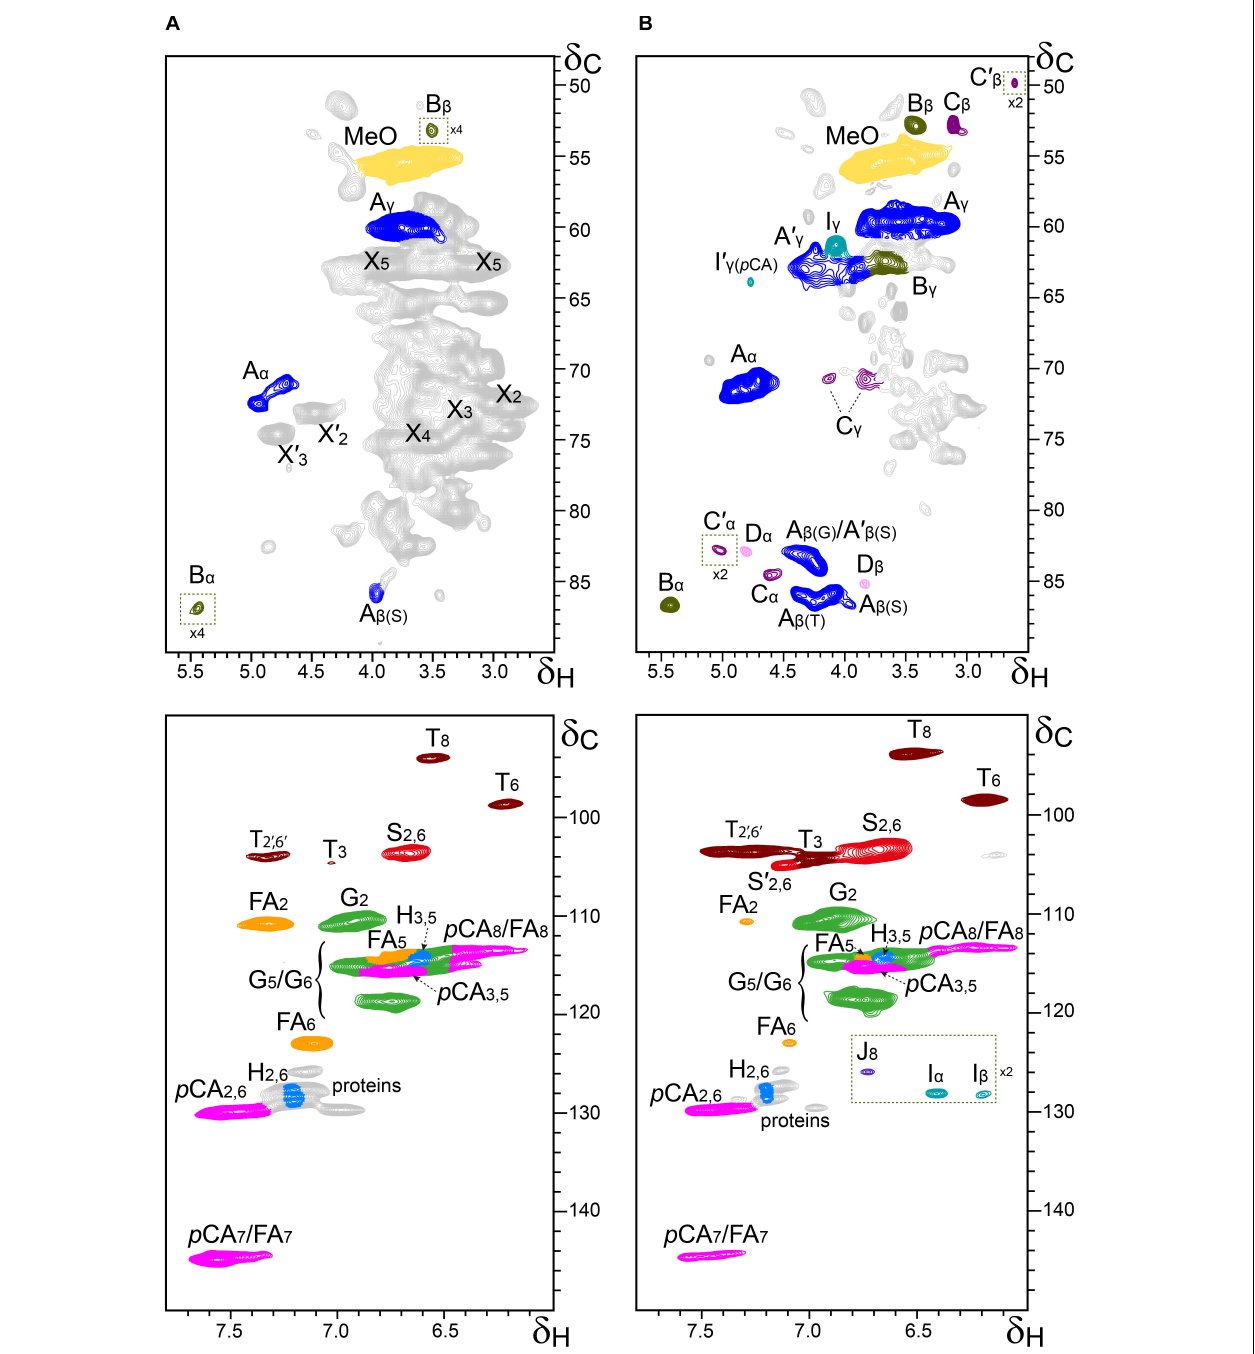
FIGURE 4 | Aliphatic-oxygenated ( δ C / δ H 48–90/2.5–5.7; top) and aromatic ( δ C / δ H 90–150/6.0–7.8; bottom) regions from the 2D-HSQC-NMR spectra (in DMSO- d 6 ) of the whole cell walls from rice straw (A) and its isolated MWL (B) . The main structures identified are drawn in Figure 5 . See Table 3 for signal assignments.